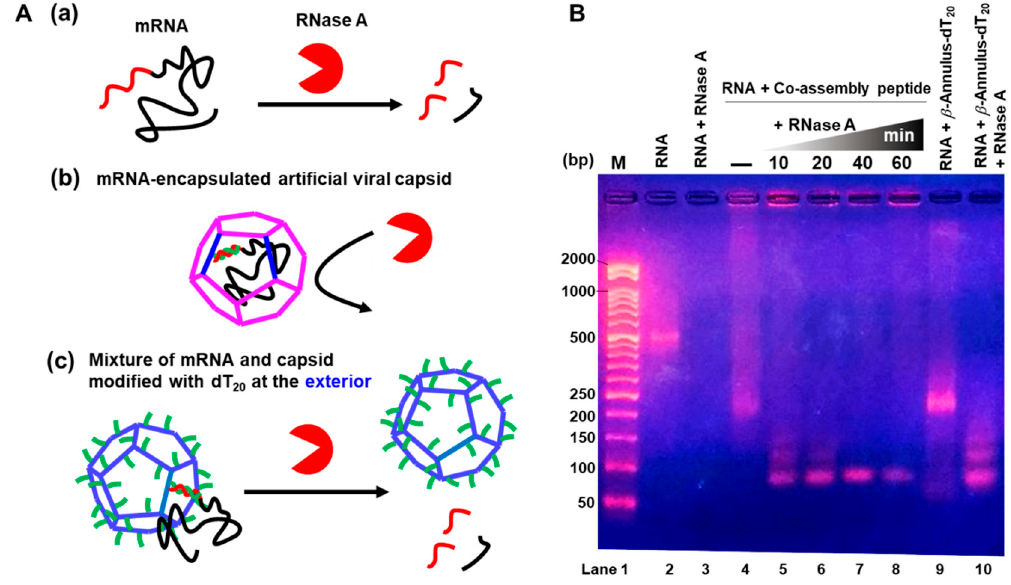
Figure 6. ( A ) Illustration of digestion of mRNA by RNase A: ( a ) mRNA alone, ( b ) mRNA-encapsulated